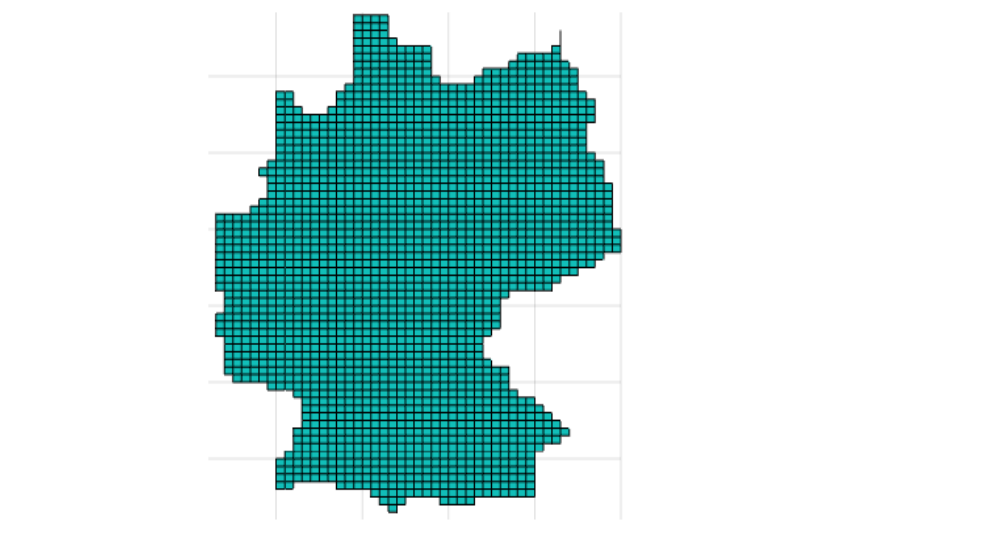
Figure 2. Rough contour of Ω and its